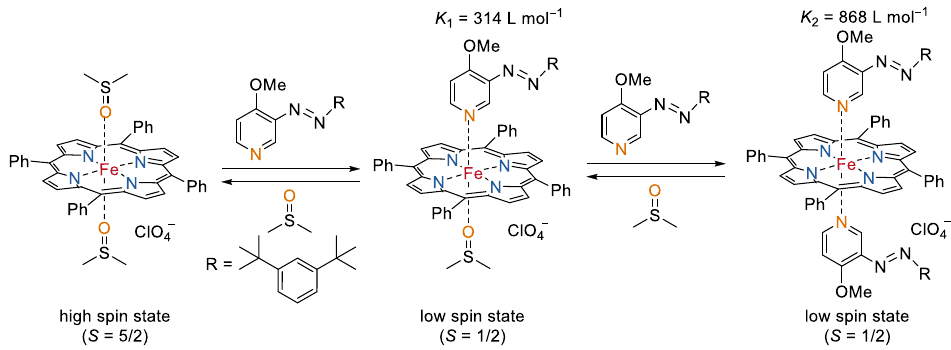
Figure 9. Switching of the spin state of Fe(III) porphyrin with the photo-switching ligand azopyridine [62]. Table 2. Protonation constant (log K 1 ) and relaxivity ( r 1 , r 2 ) for mononuclear Fe(III) complexes with macrocyclic ligands.